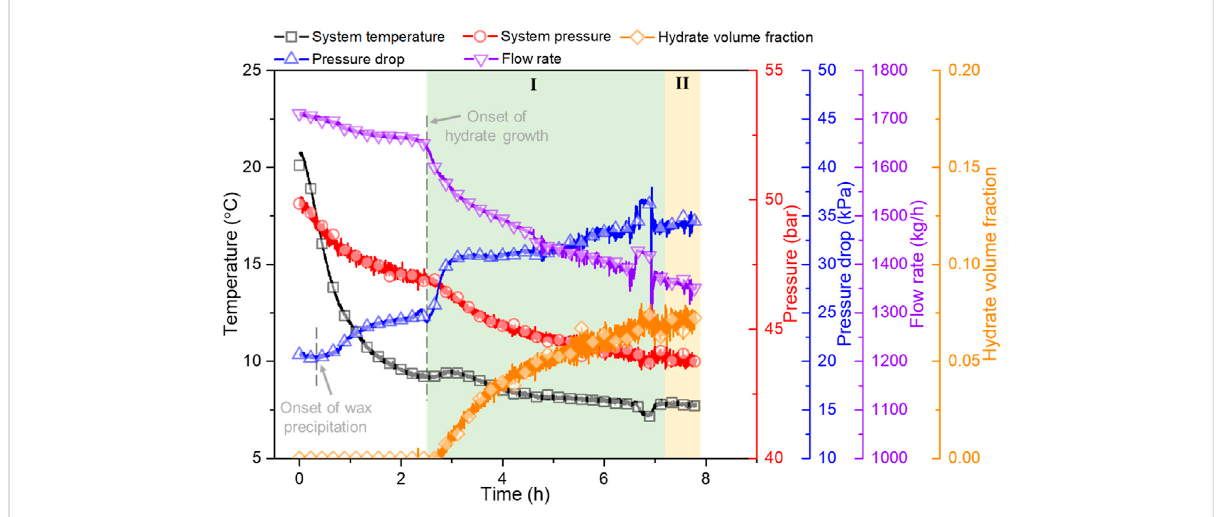
FIGURE 8 Variation trend ofsystem temperature,system pressure, pressure drop, fl ow rate,and hydratevolumefraction during theexperimentalprocess of case 7. Regions marked by I and II represent low and medium plugging risks,